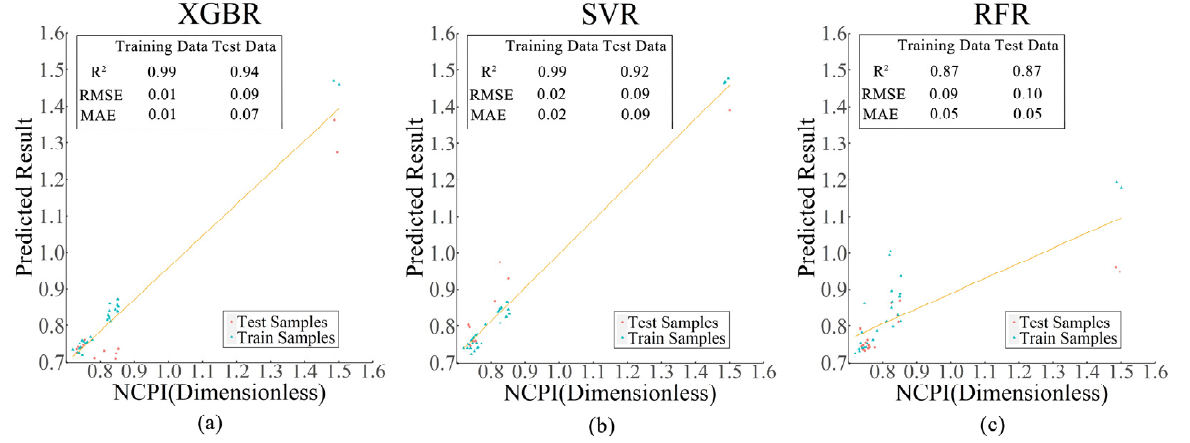
Figure 6. Scatter plot of the observed values and predicted values of NCPI using 3 regression models. ( a ) XGBR; ( b ) SVR; ( c )